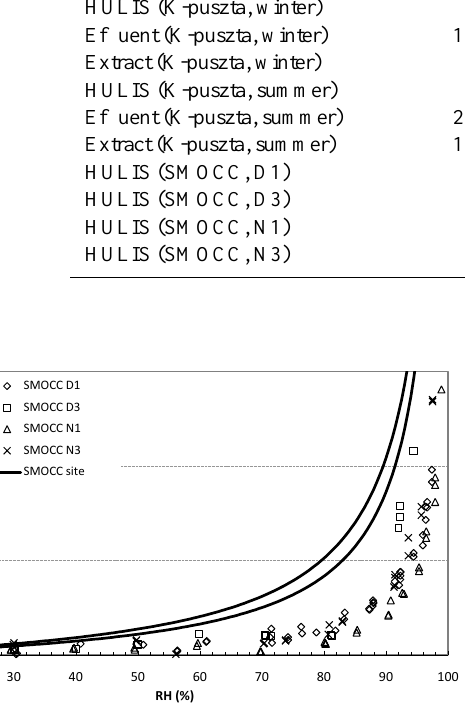
Table 3. κ R value statistics for RH values between 90 and 98%. The κ R values presented are based on the assumption that the non-ideality of the solute can be accounted for by a model salt. κ R values in parenthesis are values resulting from ideal behaviour or the droplet – assuming full dissociation. The significance of a correlation (linear increase of κ R as a function of RH) was calculated (95% CI) assuming ideal solutions. If correlations exist, there would likely be an increase in the effective number of soluble ions in the solution at increasing RH, thus, using κ R from GF measurements at 90% will probably lead to an overestimation of s c . κ R values above 90% RH [moles/m 3 ]